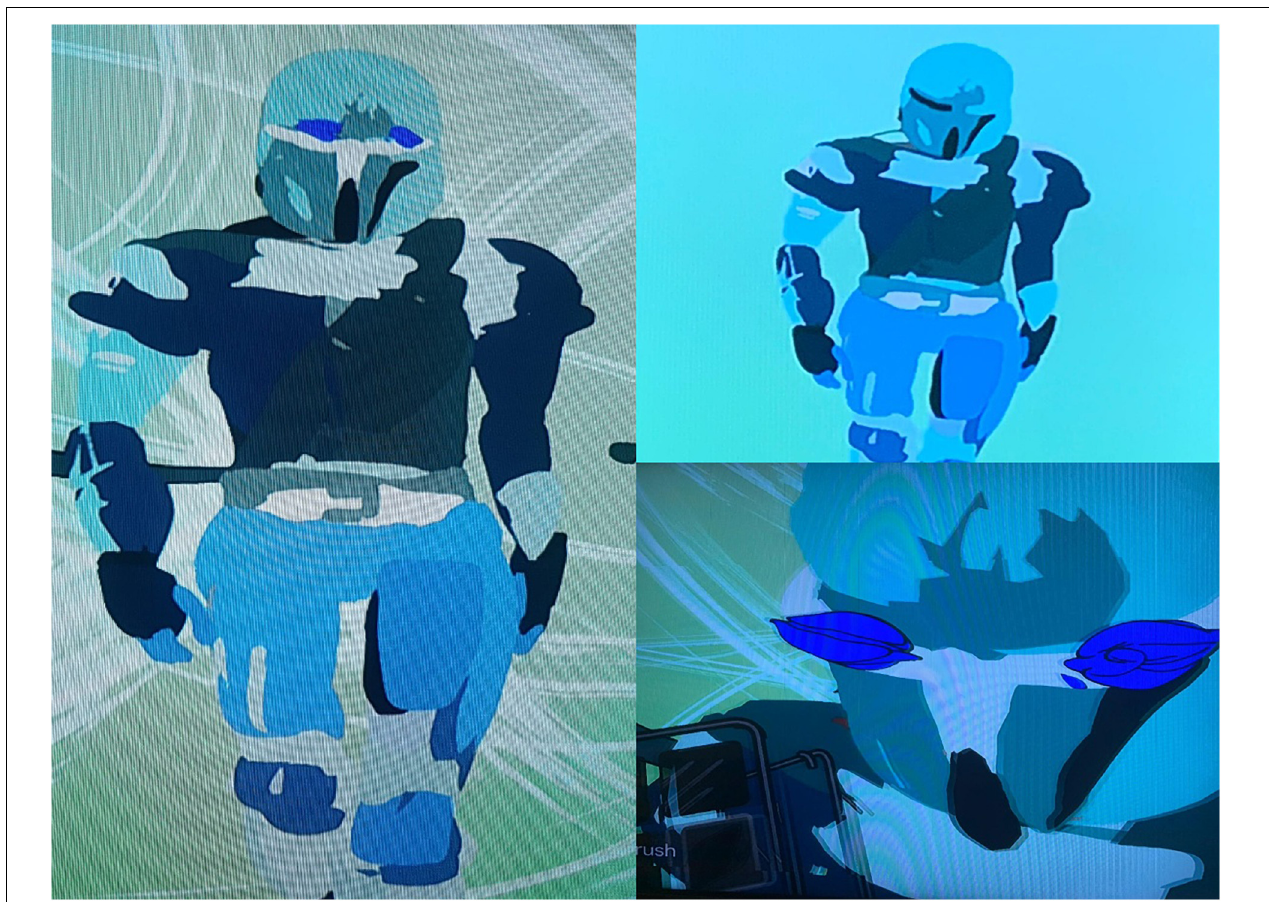
FIGURE 3 | Eric’s Iron